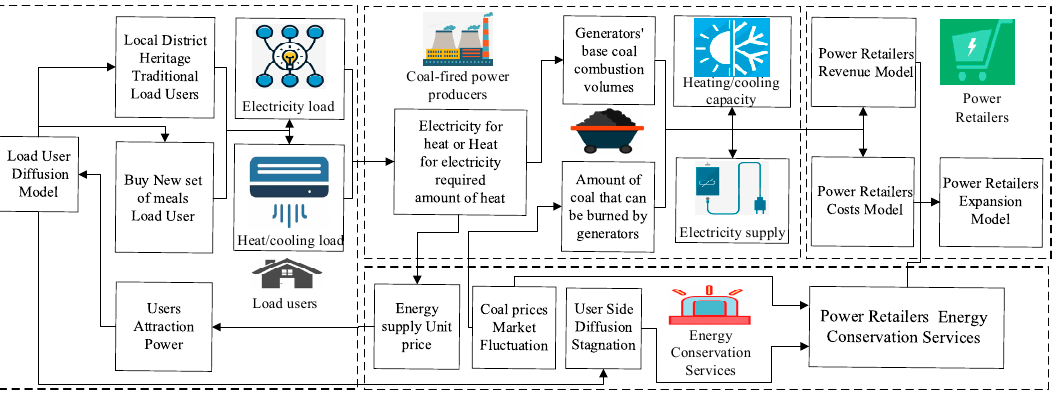
Figure 2. Modeling process of retail strategy for power retailers considering energy conservation services.